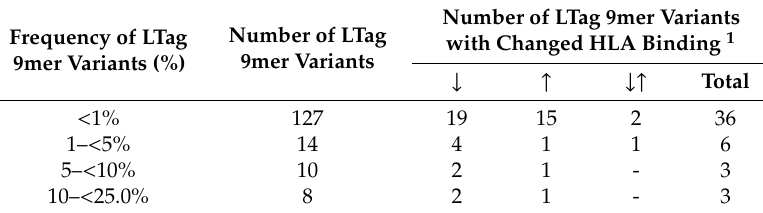
Figure 3. Frequency of aa-exchanges in 97 immunodominant LTag-9mer T-cell epitopes. Amino acid exchanges in 97 previously reported immunodominant large tumor antigen (LTag) 9mer T-cell epitopes [34,37] were identified (upper panel) and number of laboratories (lower panel) that reported the respective change in full-length BKPyV genome (black) or in partial LTag sequences (grey). Table 1. Altered HLA-A and HLA-B binding of wildtype and variant LTag-9mer T-cells